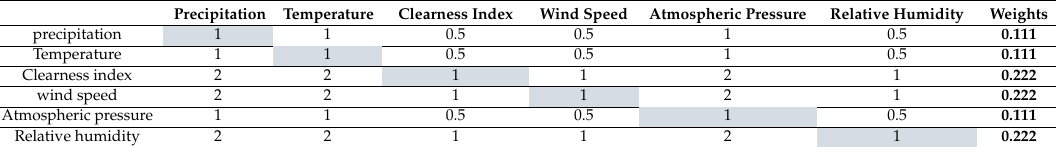
Table 9. Comparison matrix and significance weight of sub- criteria of climate.